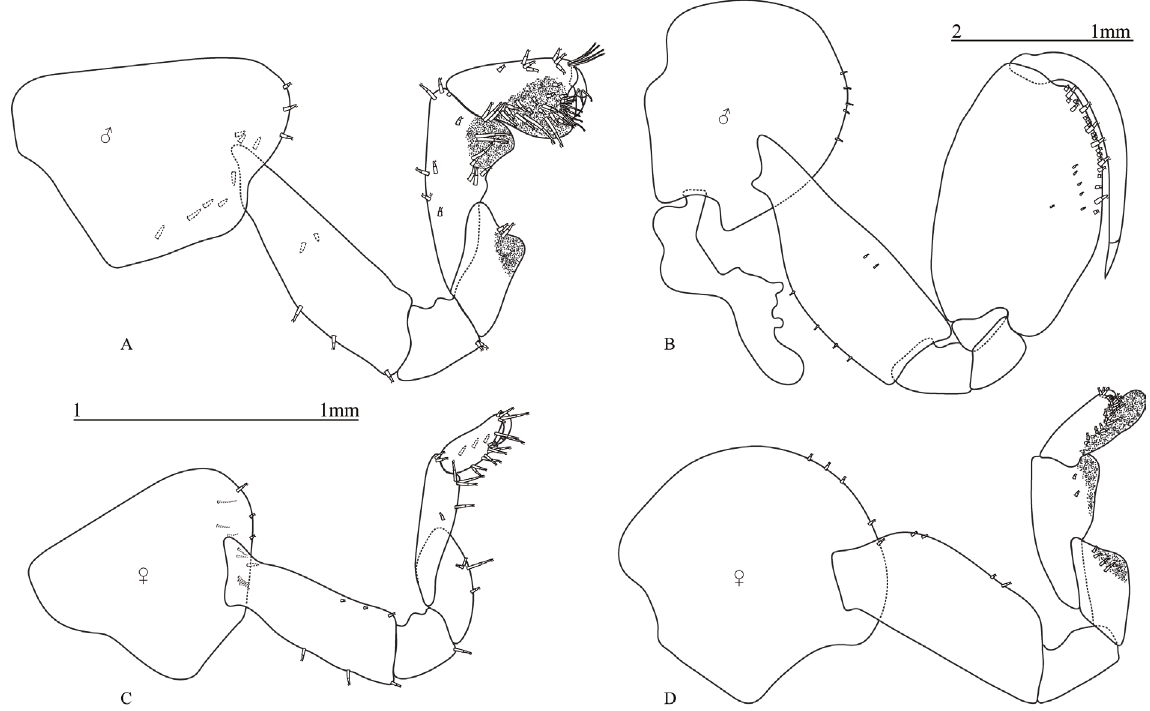
Fig. 3. Cerrorchestia taboukeli sp. nov. A–B . Holotype, ♂, 11.3 mm, MNHN-IU-2019-2276. C–D . Paratype, ♀, 9.6 mm, MNHN-IU-2019-2278. A . Gnathopod 1 (scale 1). B . Gnathopod 2 (scale 2). C . Gnathopod 1 (scale 1). D . Gnathopod 2 (scale